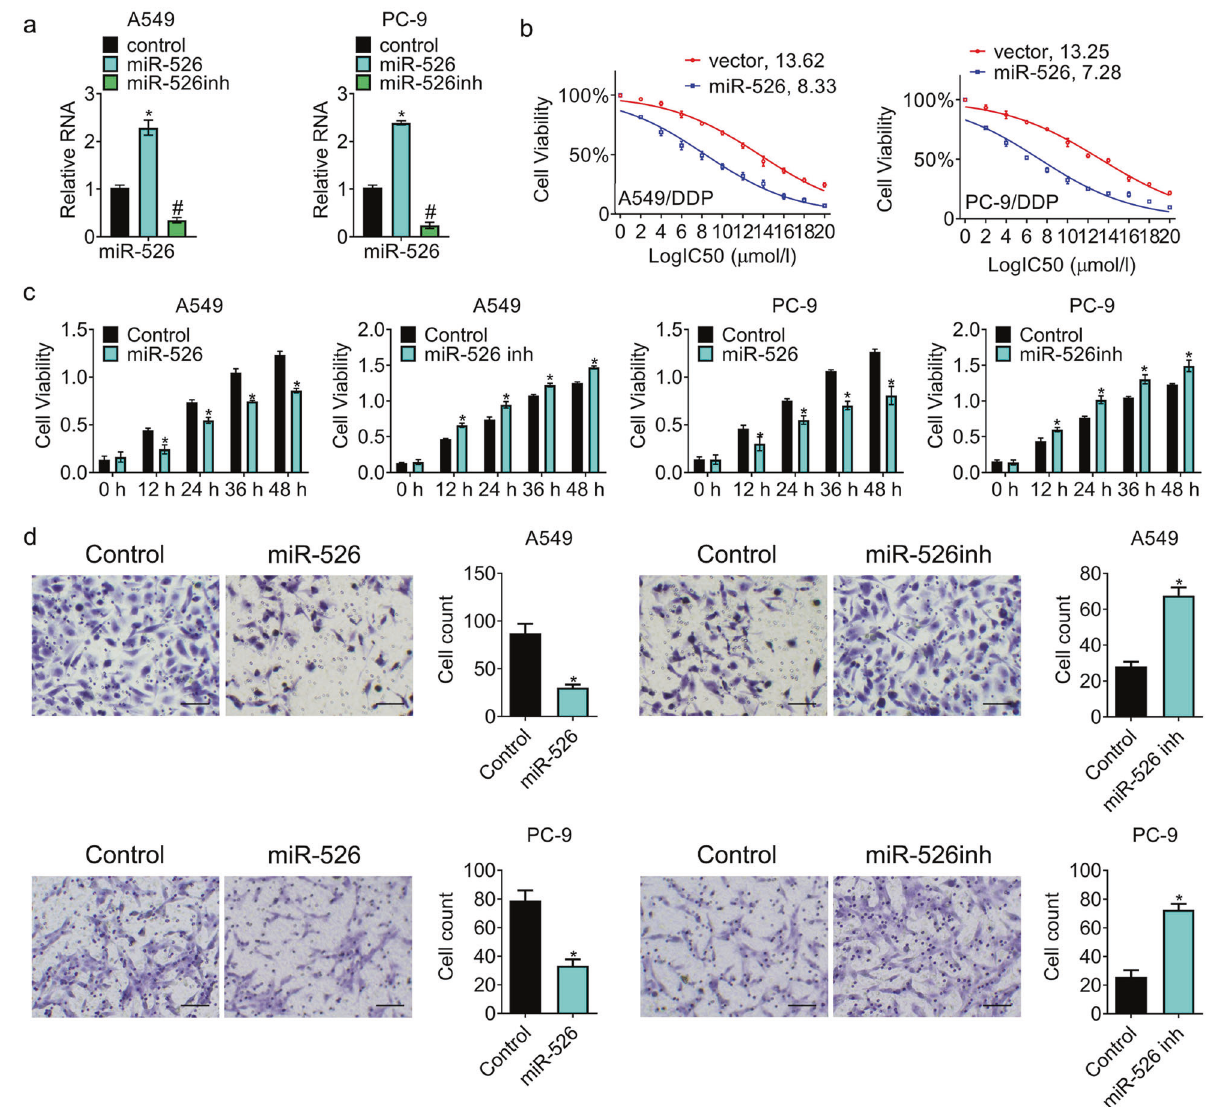
Fig. 2 miR-526b-3p overexpression suppresses resistance against cisplatin, cell growth, and migration of lung cancer. a The expression of miR-526b-3pin cells is accessed by qRT-PCR. b The viability of cells with miR-526b-3p post cisplatin exposure is determined by MTT assay. c The growth of the indicated cells is detected by MTT assay. d The migration of the indicated cells is determined by a transwell assay. *, P < 0.05 vs.